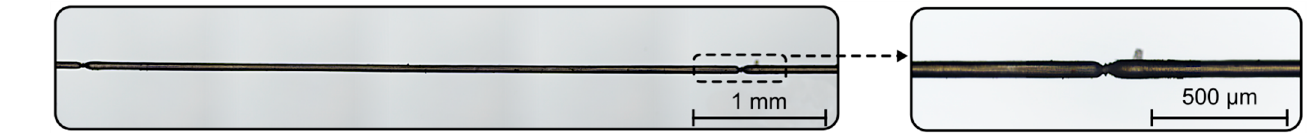
Figure 7. Microscopic images of stitching errors.